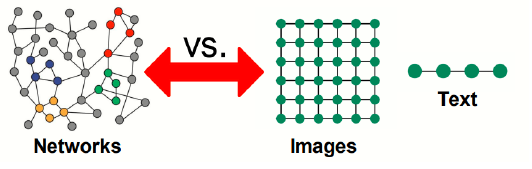
Figure 4 : Network structure vs image